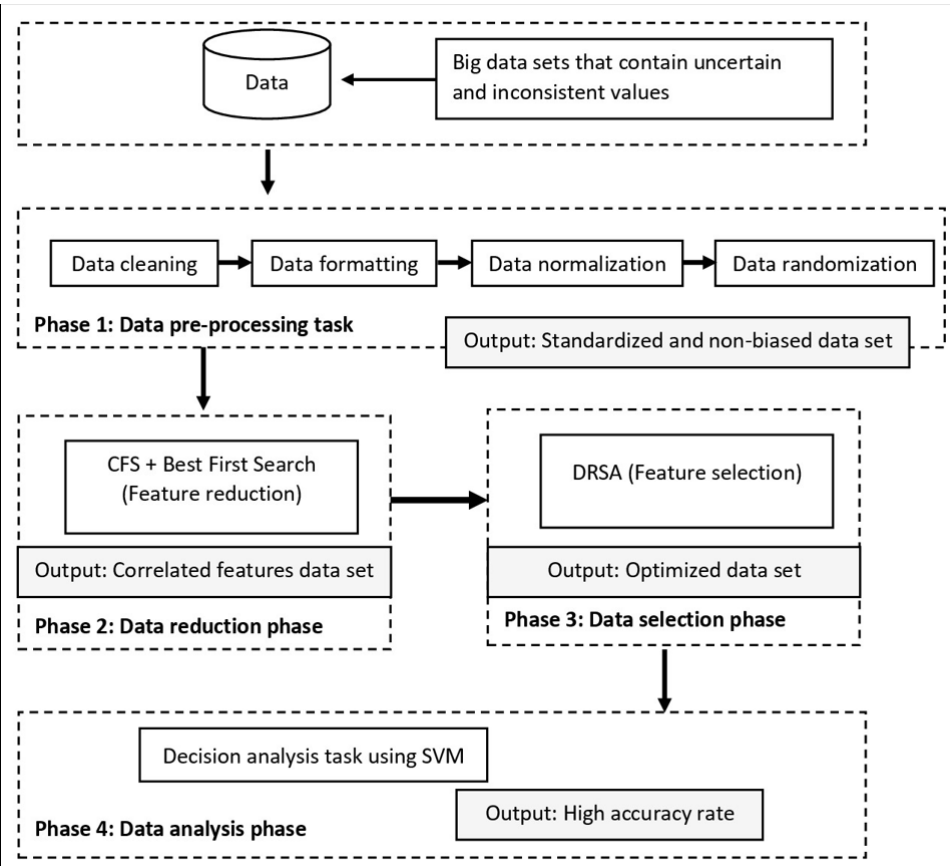
Figure 1. The hybrid correlation-based feature selection dominance-based rough set approach (CFS-DRSA)